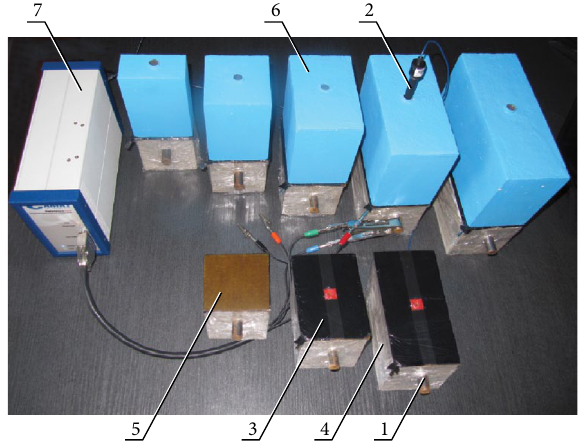
Fig. 3. Stand for impedance tests of the reinforcement of concrete specimens: 1 – working electrode, 2 – reference electrode, 3 – counter electrode, 4 – foil, 5 – felt, 6 – concrete ballast, 7 – potentiostat